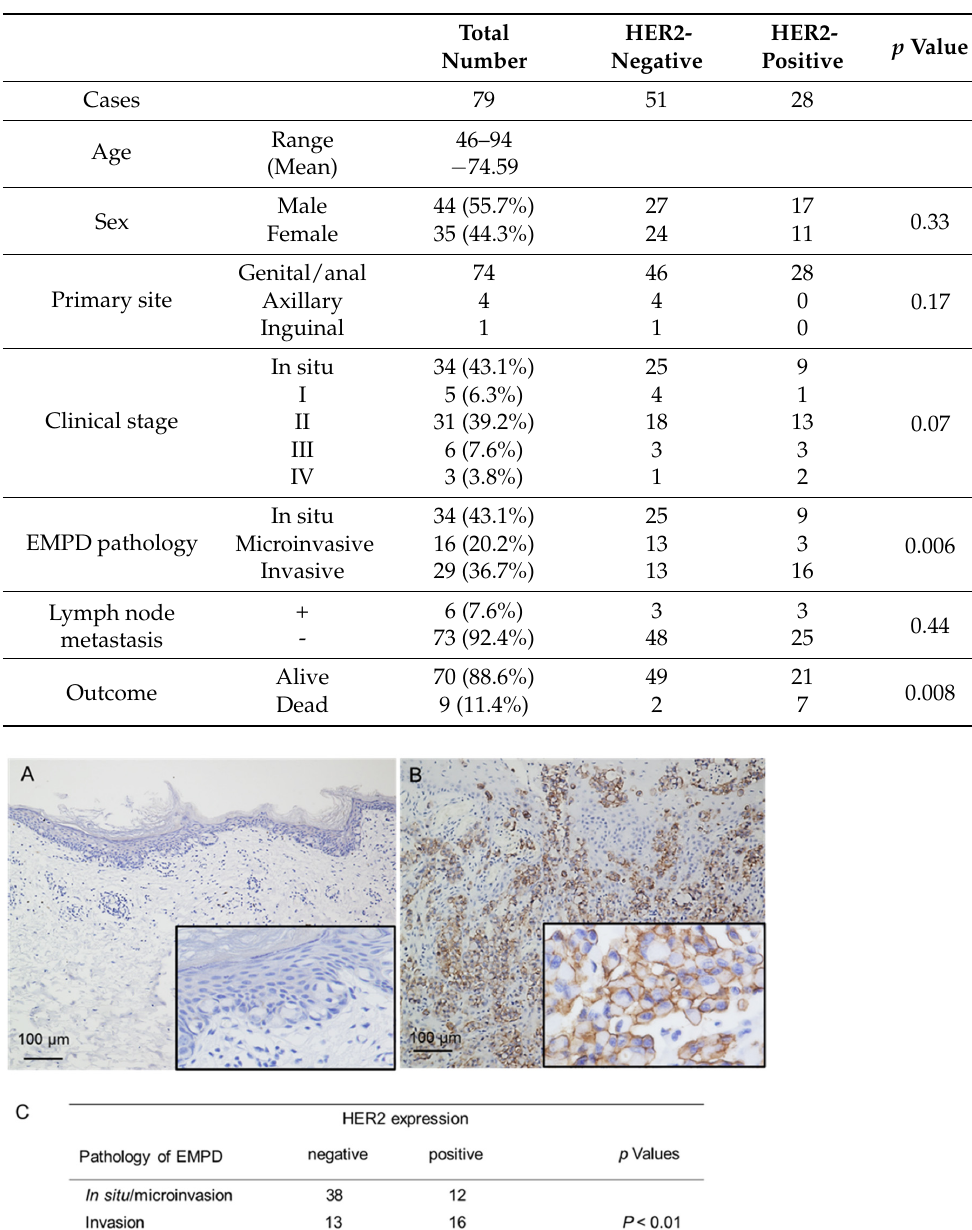
Table 1. Clinical summary of the 79 EMPD patients.